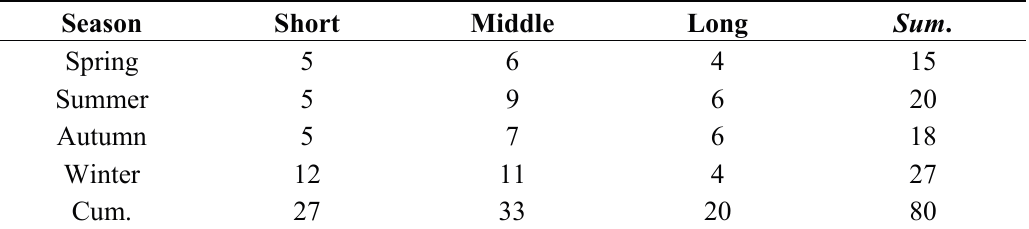
Table 3. Number of PPEs with durations of different levels in each season.